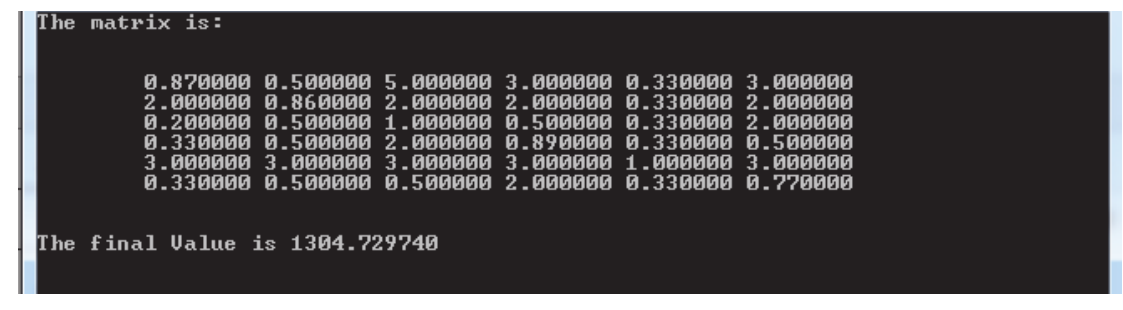
Fig. 3. Permanent function value for alternative 2